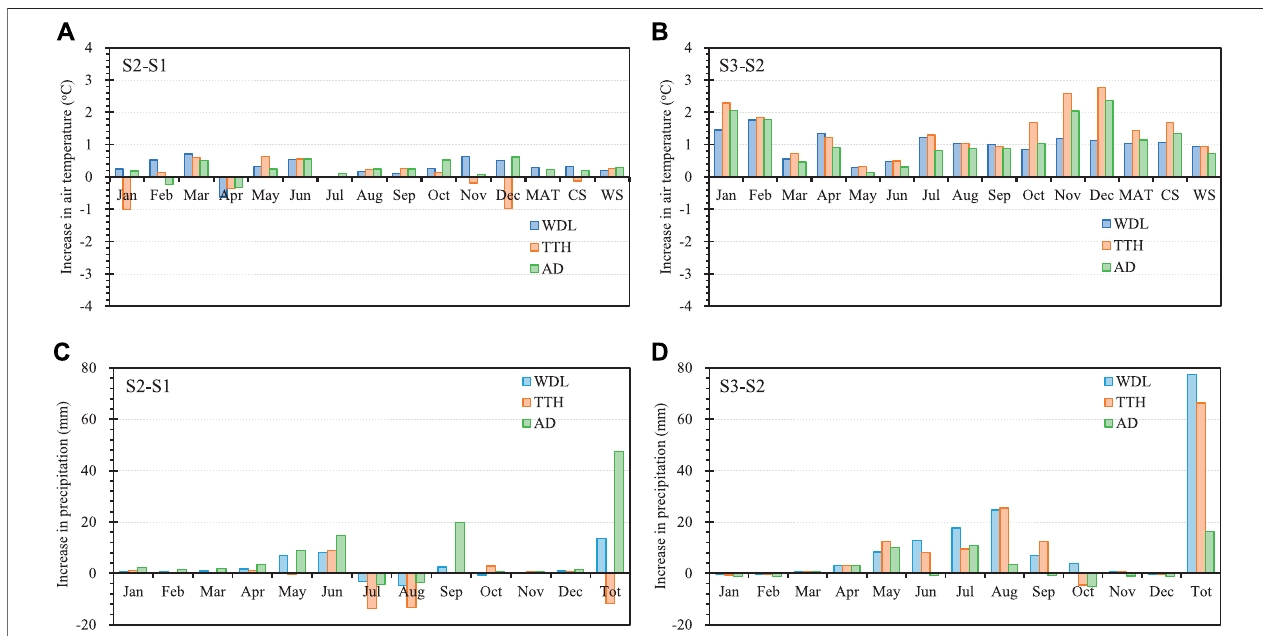
FIGURE 5 | Periodic changes in mean monthly, mean annual (MAT), cold season (CS), and warm season (WS) air temperature at the three weather stations. (A) Temperaturechangesfromstage1(S1,before1979)tostage2(S2,1980 – 1999)and (B) fromstage2(S2,1980 – 1999)tostage3(S3,2000 – 2019).Periodicchangesin mean monthly and total precipitation (Tot) at the three weather stations. (C) Precipitation changes from stage 1 (S1, before 1979) to stage 2 (S2, 1980 – 1999) and (D) from stage 2 (S2, 1980 – 1999) to stage 3 (S3, 2000 – 2019).